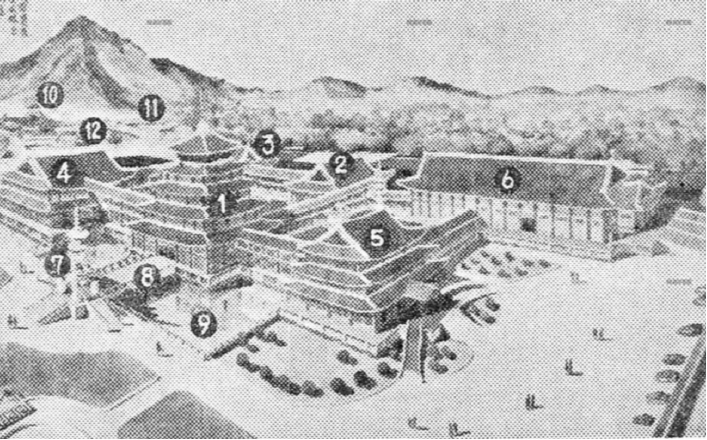
Figure 21. Perspective Drawing of the Winning Design for the National Museum (1966, Dong-A Daily News).